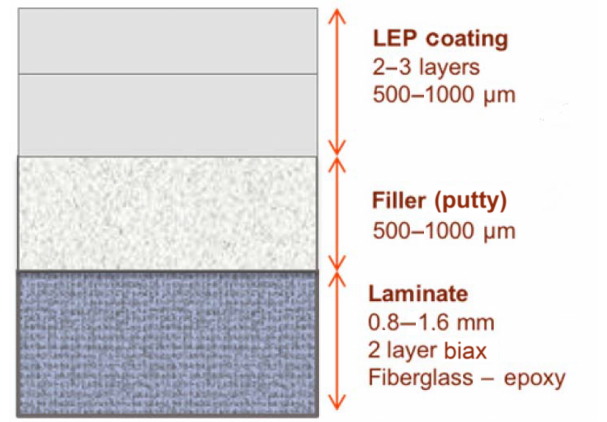
Figure 1. Example of leading-edge protection system configuration (Cortés et al.,